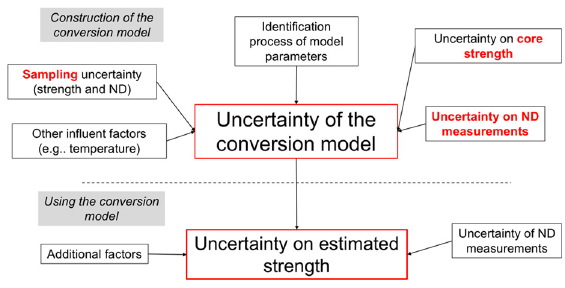
Figure 2. Uncertainties arising in the different stages of the strength estimation